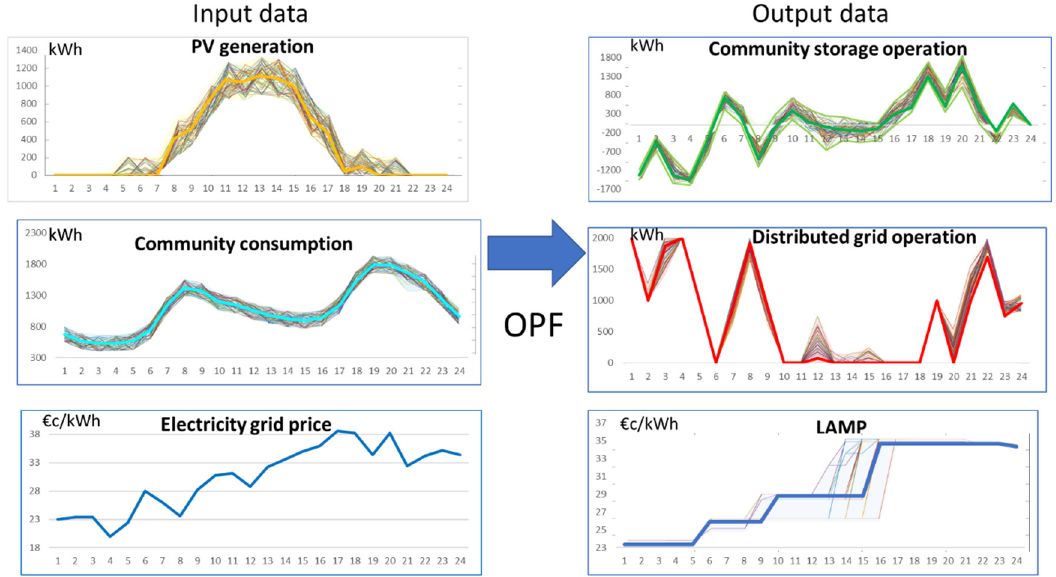
Figure 12. DA-OPF evaluation—example of DA-OPF analyses (winter case).